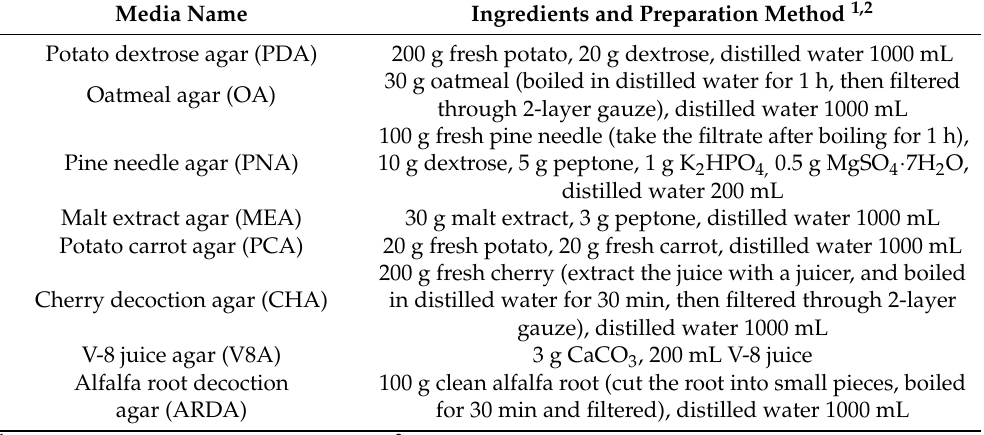
Table 1. Test media and the preparation